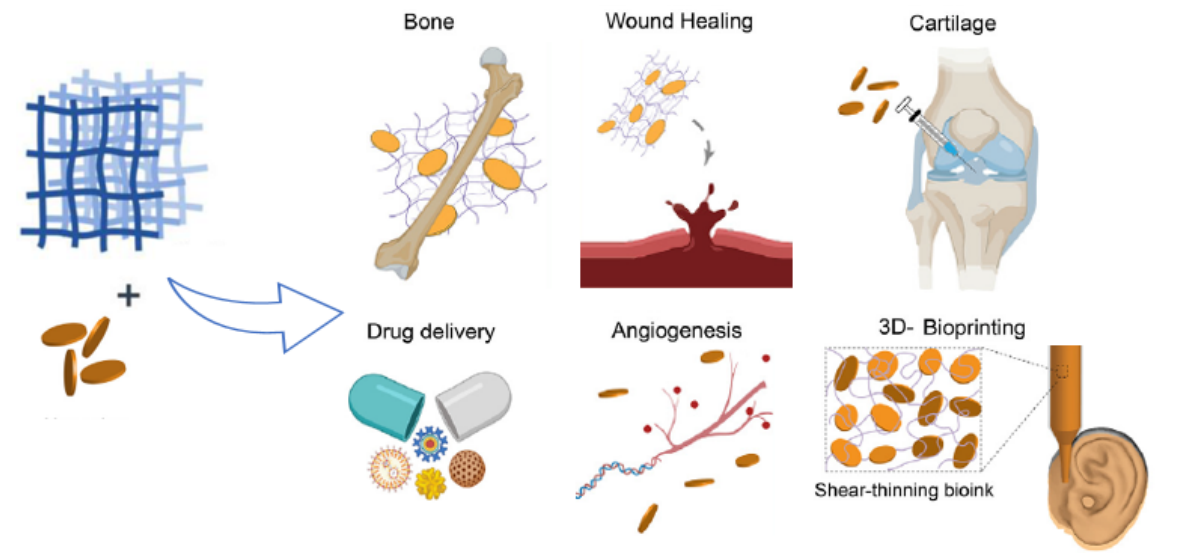
Figure 6. Schematic representation showing the broad applicability of clay-based nanocomposite hydrogels in the biomedical industry. (Adapted with permission from [26]. Copyright 2021, Else- vier).